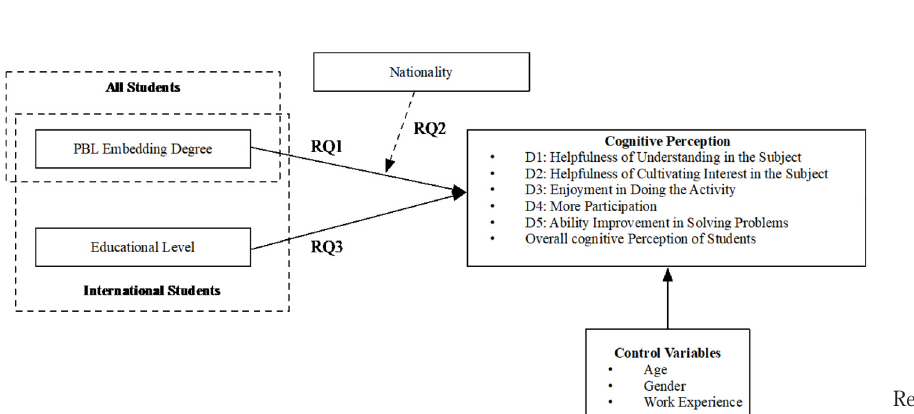
Figure 1. Parallelism of